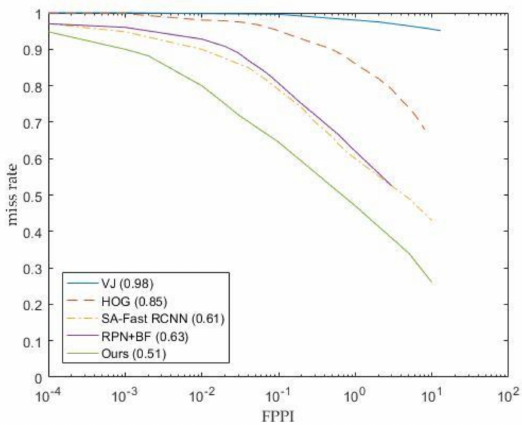
Figure 3. The curve of false positive per image (FPPI)-miss